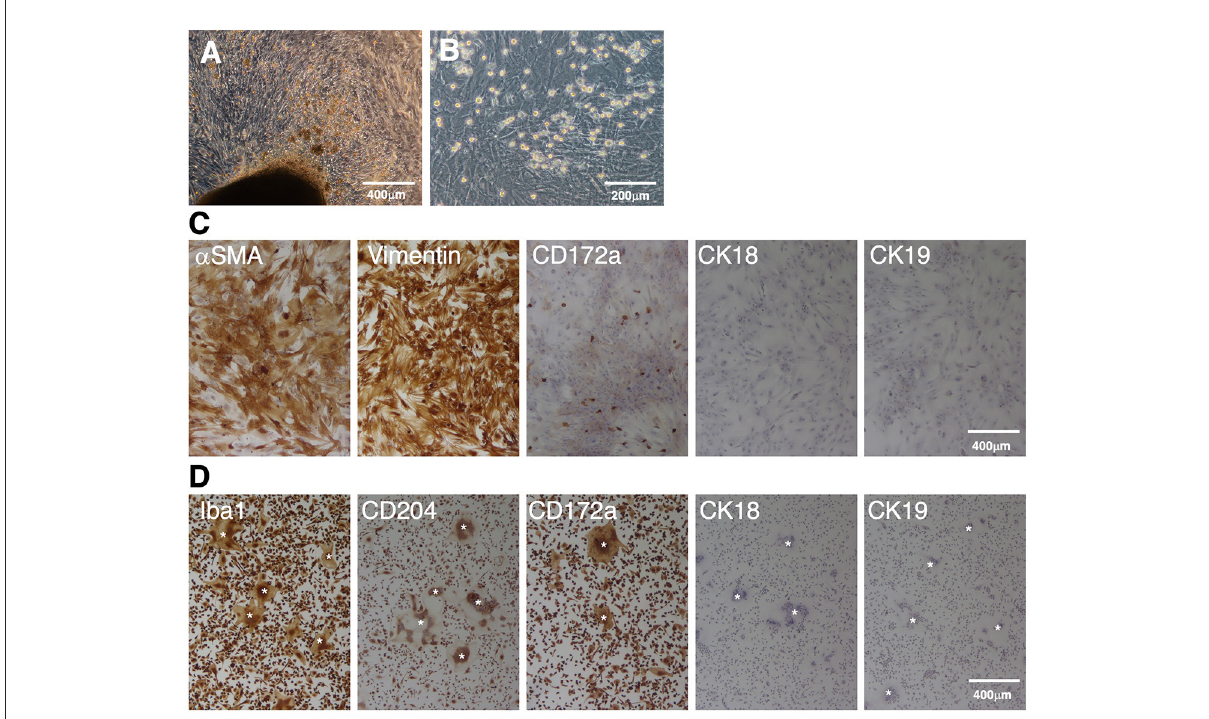
FIGURE1 Immunocytochemical characterization of a mixed primary culture of fetal porcine small intestine-derived cells and isolated PIM. Primary intestinal cells cultured in T-75 tissue culture flasks (A) or TC-dishes (B) were observed under a phase-contrast microscope. The cells were seeded in 8-well-chamber slides, fixed using 4% paraformaldehyde phosphate buffer solution, and immunostained with specific antibodies against mesenchymal ( α SMA and vimentin), macrophage (CD172a), or epithelial (CK18 and CK19) cell markers [ (C) , brown]. The PIM isolated from the supernatant samples of the mixed primary culture were immunostained with specific antibodies against macrophage (Iba1, CD204, and CD172a) or epithelial (CK18 and CK19) cell markers [ (D) , brown )]. Multinucleated giant cells were sometimes observed in the PIM culture [ (D) , white asterisks ]. All nuclei were counterstained with hematoxylin [ (C,D) , blue ]. Images are representative of two independent experiments.